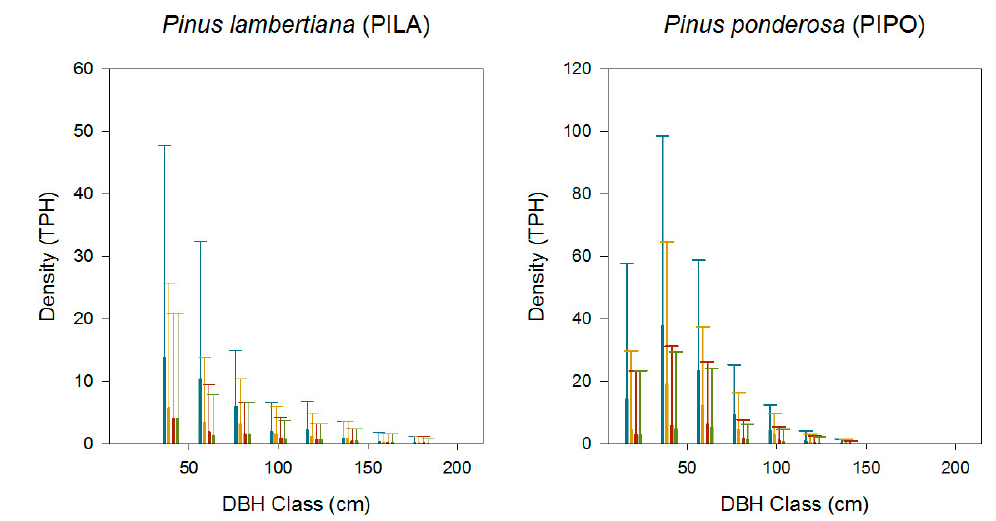
Figure 3. Diameter distribution (20 cm diameter classes) by species recorded as alive in Spring 2015 (SPR15—blue bar), Summer 2015 (SUM15—gold bar), Summer 2016 (SUM16—red bar), and Summer 2017 (SUM17—green bar) in the Southern Sierra Nevada. Table 2. Mean and standard deviation (range) of DBH and height for living overstory trees (>25.4 cm DBH) in spring 2015 and summer 2017. DBH and height were not statistically different